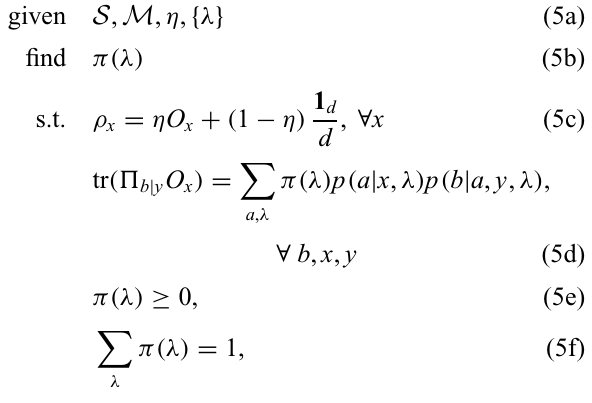
(cid:7) 1 | y . Measurements η } b in a b | u